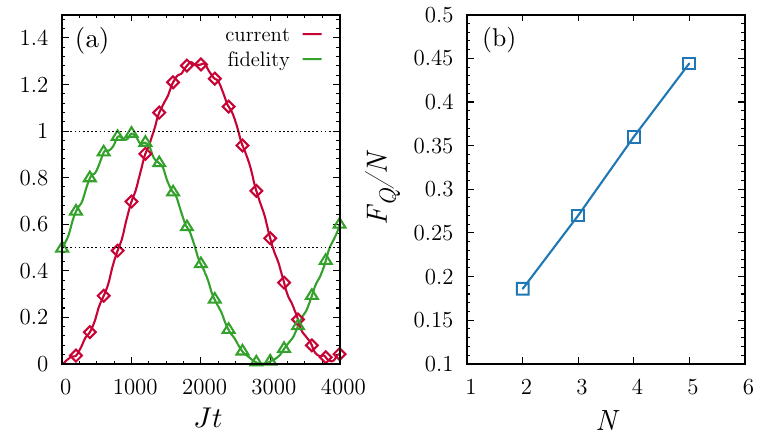
Figure 5: Creation of entangled states of angular momentum with quantum soli- tons. a Exact many-body dynamics of the current (in units of the hopping constant = 0 to Ω / Ω = 1 / 2. Here we set N = 28, N = 3, J ) following a quench from Ω / Ω s 0 0 / J = 0.015. At one quarter of oscillation period, the superpo- U / J = − 0.51 and ∆ 0 ( | l = 0 〉 + | l = N 〉 ) is formed, with a fidelity very close to 1. No fine sition | ψ 〉 = 1 (cid:112) z z 2 tuning of parameter is required. b Scaling of the quantum Fisher information with ∝ N 2 . The system particle numbers, showing that it reaches the Heisenberg limit F Q parameters are described in the supplementary